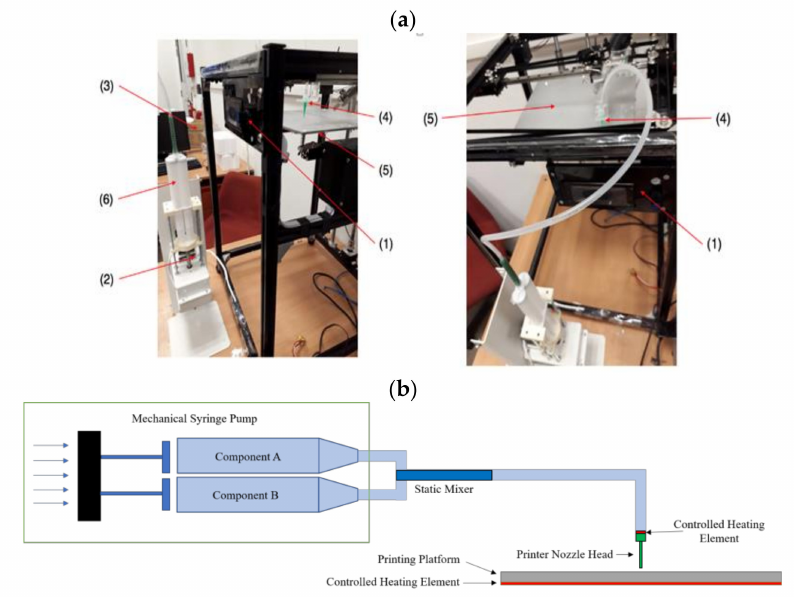
Figure 2. ( a ) Photographs: (1) motion control platform, (2) discovery extruder, (3) static mixer, (4) printer nozzle head, (5) heated printer bed platform, (6) double-barrel-syringe and ( b ) simplified schematic of experimental setup for heat-cure extrusion-based